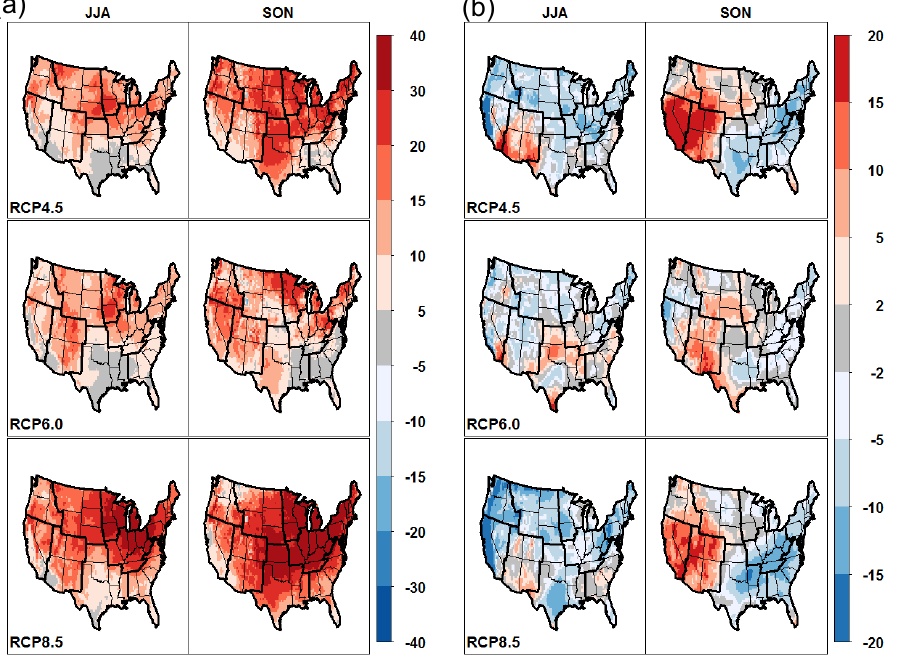
Figure 12. Projected changes (%) in summer and autumn averages of biogenic isoprene emissions (a) and cloud fraction (b) between 1995– 2005 and 2025–2035 under RCP4.5, RCP6.0, and